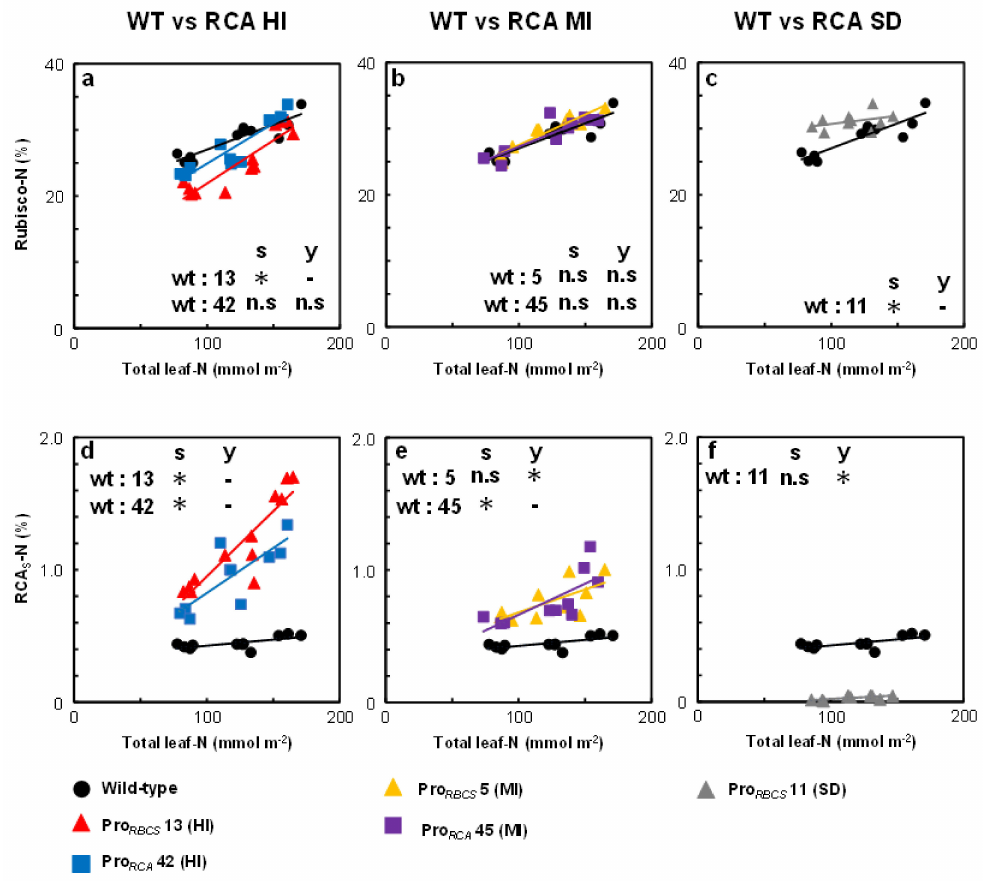
Figure 4. Relationships between Rubisco-N and RCA S -N and total leaf-N contents in RCA transgenic plants. The data were taken from Figures 2 and 3. ( a–c ) Relationships between Rubisco-N and total leaf-N and ( d–f ) RCA S -N and total leaf-N in uppermost, fully expanded leaves. The black circle, red triangle, blue square, yellow triangle, purple square, and grey triangle indicate wild-type, Pro RBCS 13 (HI), Pro RCA 42 (HI), Pro RBCS 5 (MI), Pro RCA 45 (MI), and Pro RBCS 11 (SD) plants, respectively. The asterisks denote a statistically significant di ff erence, as assessed by analysis of covariance (ANCOVA) ( p < 0.05) performed on the slope (s) and y-intercept (y) of the linear regressions between wild-type and RCA transgenic plants, respectively. The details of the statistical treatments are presented in Tables S1 and